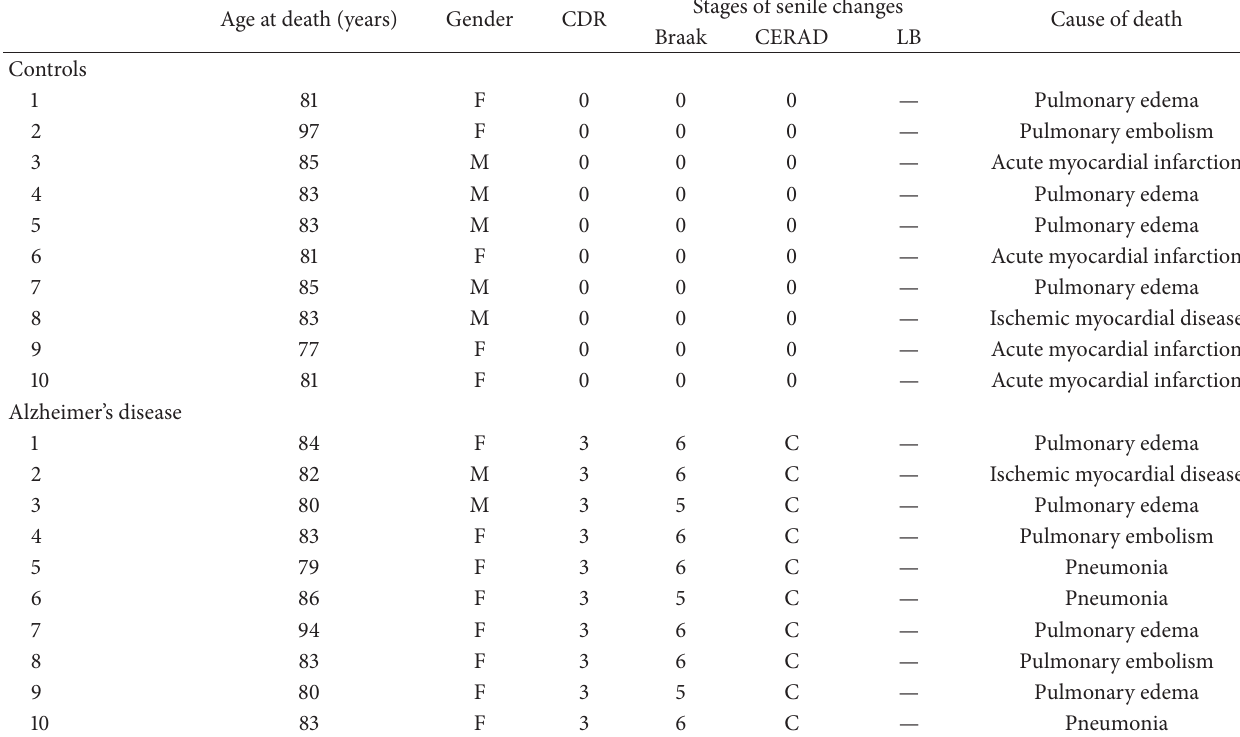
Table 1: Clinical data of control and Alzheimer’s disease individuals investigated in the methylation